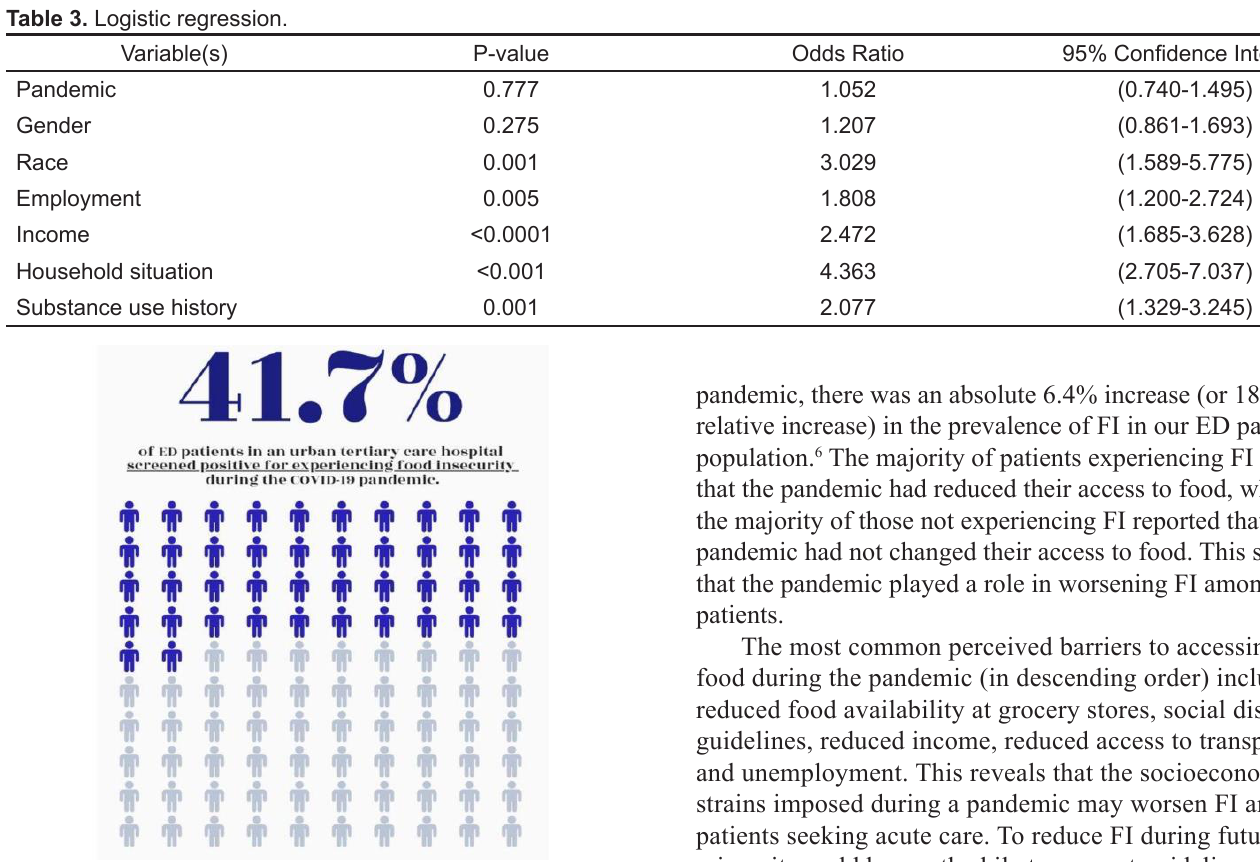
Figure 2. Prevalence of food insecurity in the emergency department patient population during the COVID-19